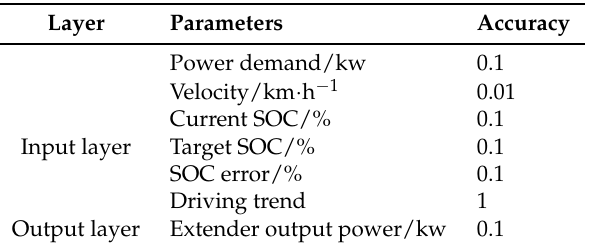
Table 2. Training data accuracy settings.